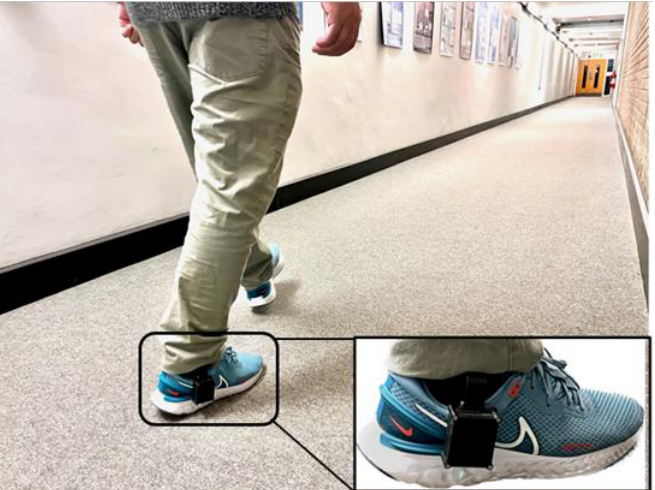
Figure 6. A photo showing level walking along a 28 m indoor corridor with the device attached to the footwear.